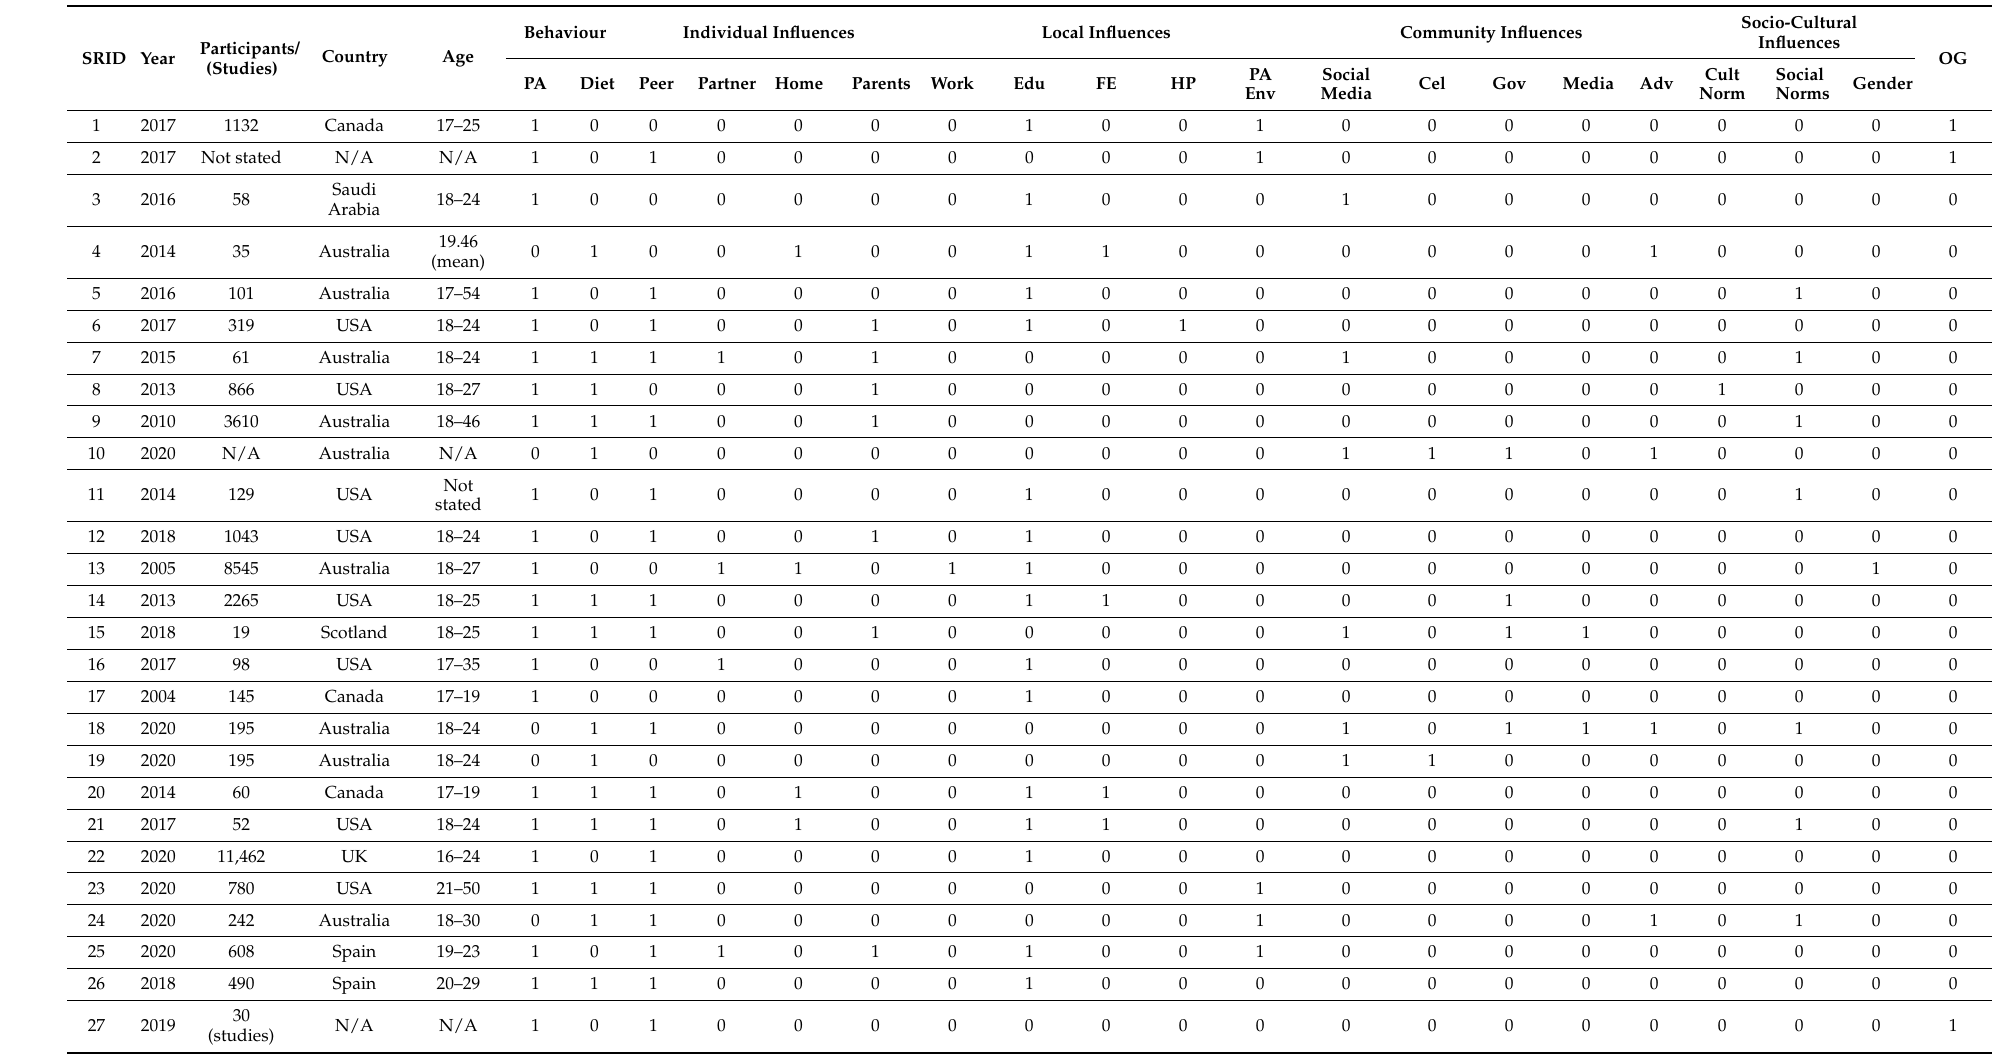
Table 1. Characteristics of scoping review studies—all